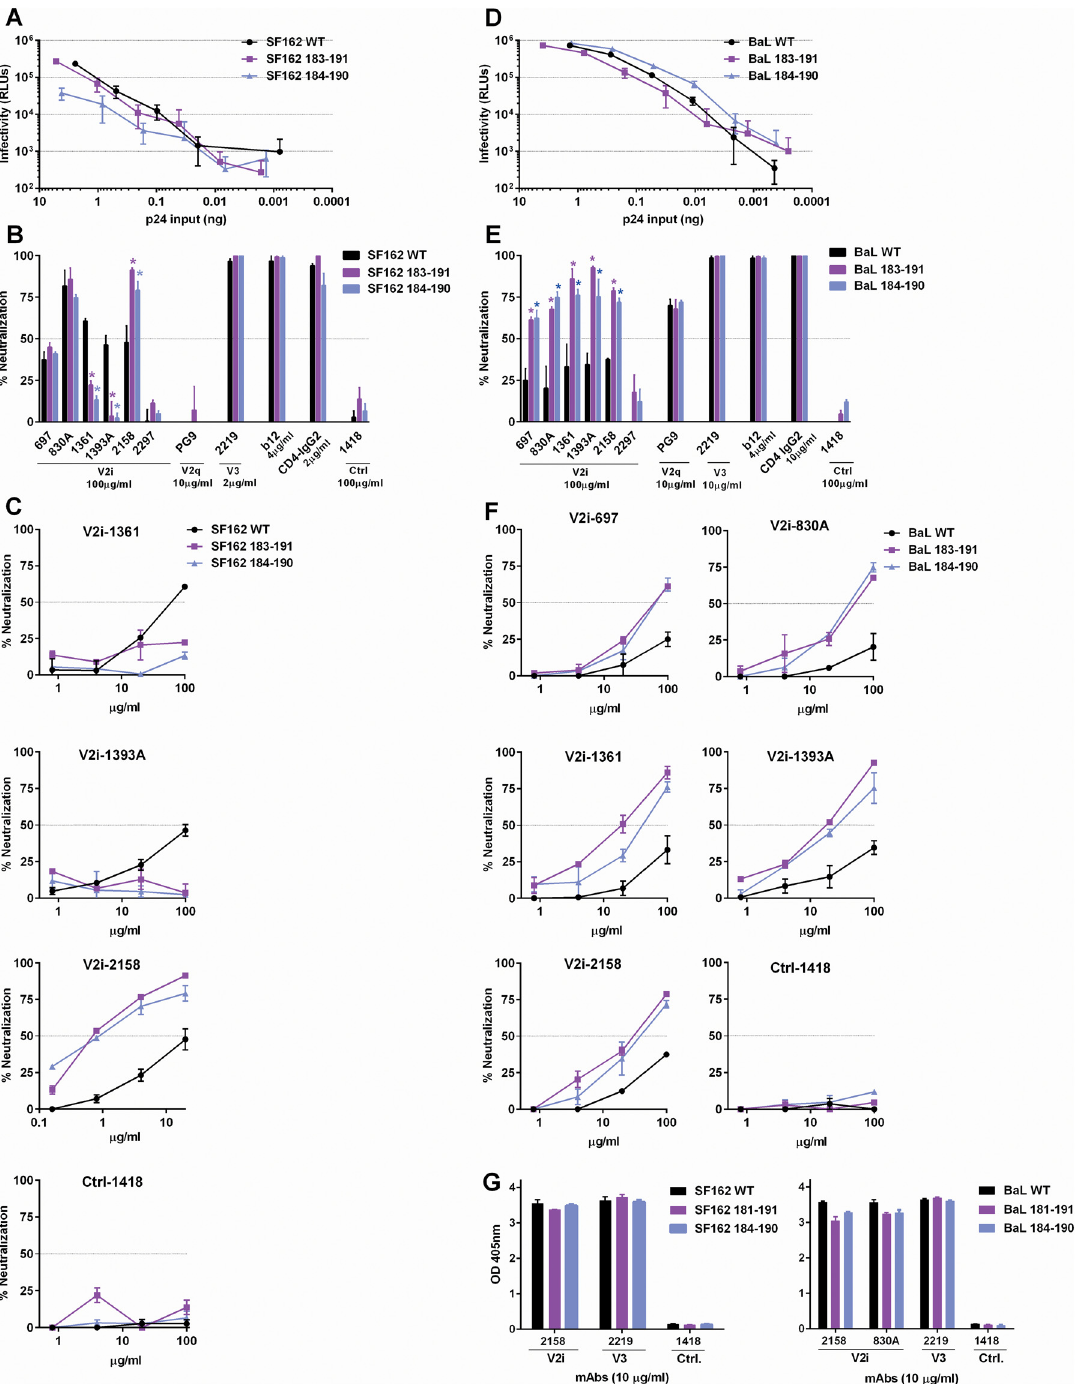
Fig 5. Addition of a disulfide bond to the hypervariable V2 loops of SF162 and BaL modulates virus sensitivity to V2i mAbs. (A) Infectivity of SF162 WT and its disulfide mutants in TZM-bl cells. (B) Neutralization of SF162 WT and its disulfide mutants by V2i and other mAbs. (C) Titration curves showing differences in neutralization sensitivity of SF162 WT and mutants to V2i mAbs 1361, 1393A, and 2158. (D) Infectivity of BaL.01 and its disulfide mutants in TZM-bl cells. (E) Neutralization of BaL.01 and its disulfide mutants by V2i and other mAbs. (F) Titration curves showing differences in neutralization sensitivity of BaL.01 WT and mutants to V2i mAbs 697, 830A, 1361, 1393A, and 2158. Statistical analyses were performed for neutralization curves reaching above 50%. * , p < 0.05 based on two-way ANOVA test of the mAb titration data. (G) ELISA reactivity of V2i, V3, and control mAbs with gp120 from WT or S-S mutants of SF162 and